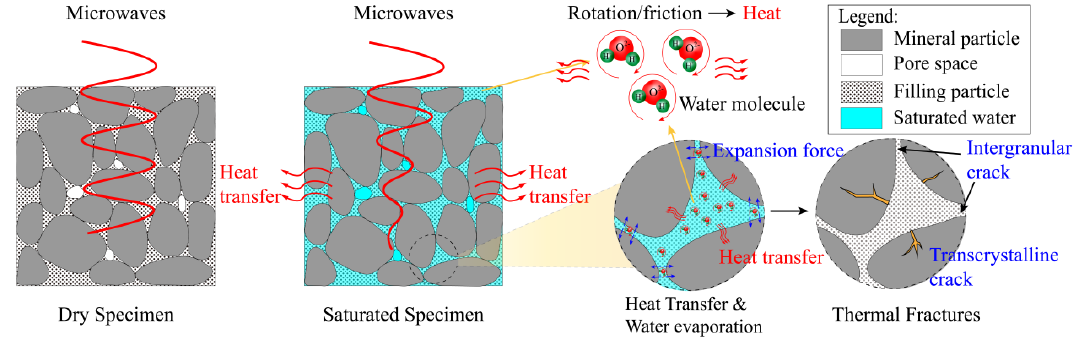
Figure 23. Microwave heating process and damage mechanisms of water-bearing sandstone.